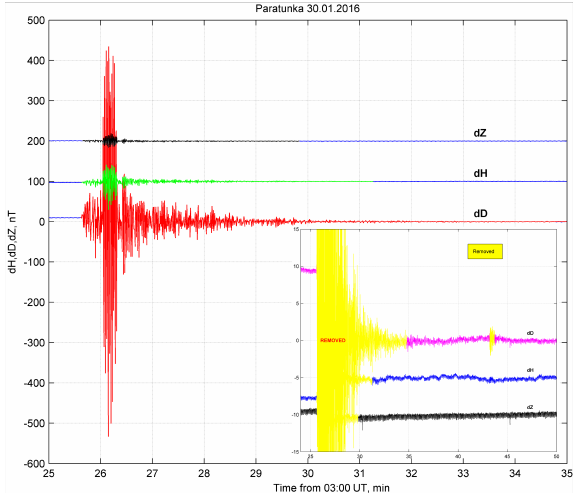
Figure 13. Example of manifestation of a nearby earthquake on 30 January 2016 (magnitude 5.7, distance is about 100km) in the record of FGE magnetometer with a suspended system at the Paratunka observatory. The inset shows the results of data clear- ing performed by a magnetologist using a semi-automatic proce- dure (shown in yellow). In component D the effect of an aftershock, which occurred in 17min, is also removed. Jumps of average level of the records, reaching 10nT in D (about 1.5 (cid:48) ) are clearly visible in the inset.